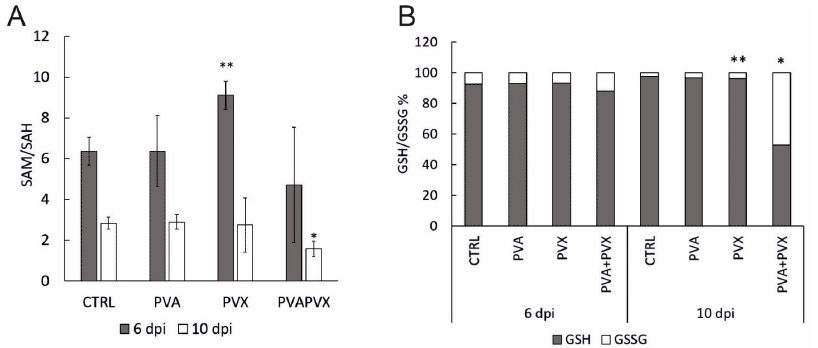
Figure 6. ( A ) SAM/SAH ratio and ( B ) glutathione balance in local (6 dpi) and systemic (10 dpi) leaves of healthy controls, PVA and PVX single infections and the PVA + PVX co-infection. Results are shown from one independent experiment, error bars in A) represent standard deviation and statistical significance was calculated using Student’s t -test (* p < 0.5, ** p < 0.01).